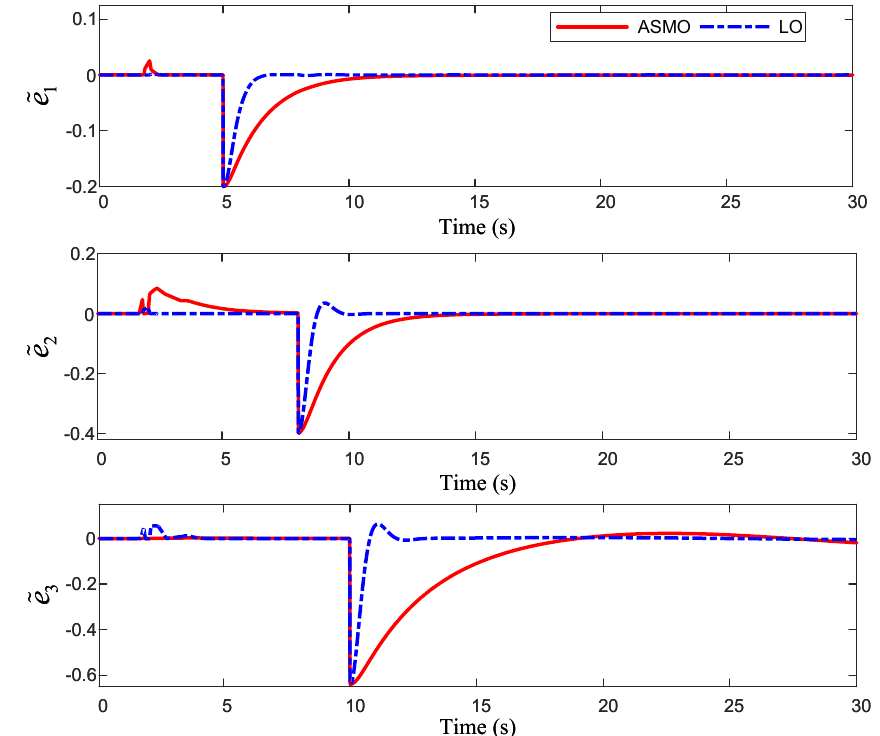
Figure 3. The estimation error of fault.